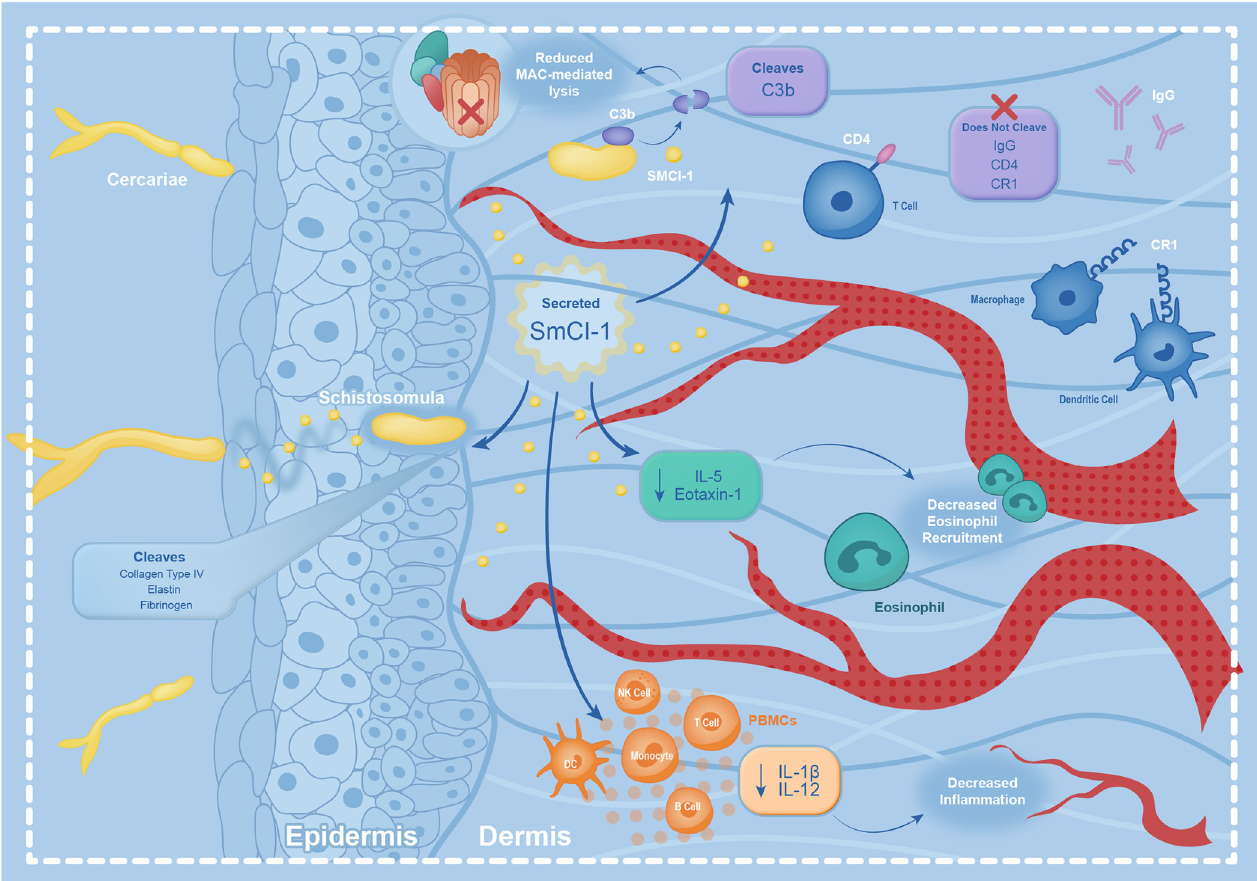
Fig 10. SmCI-1 functions in numerous ways suggesting a key role in host penetration and survival during the initial stages of intra-human infection. These include the degradation of host ECM factors involved in the integrity of the skin. It also includes the targeted cleaving of complement component C3b, which leads to the reduction of complement mediated lysis of the parasite. It also includes the reduction of IL-5 and Eotaxin-1 production, an observation suggesting a role in reducing eosinophil recruitment and development. Finally, the reduction of IL-1 β and IL-12 caused by SmCI-1 is indicative of a reduction in inflammation in the skin, which might explain the lack of swelling and site-specific inflammation seen during most S . mansoni